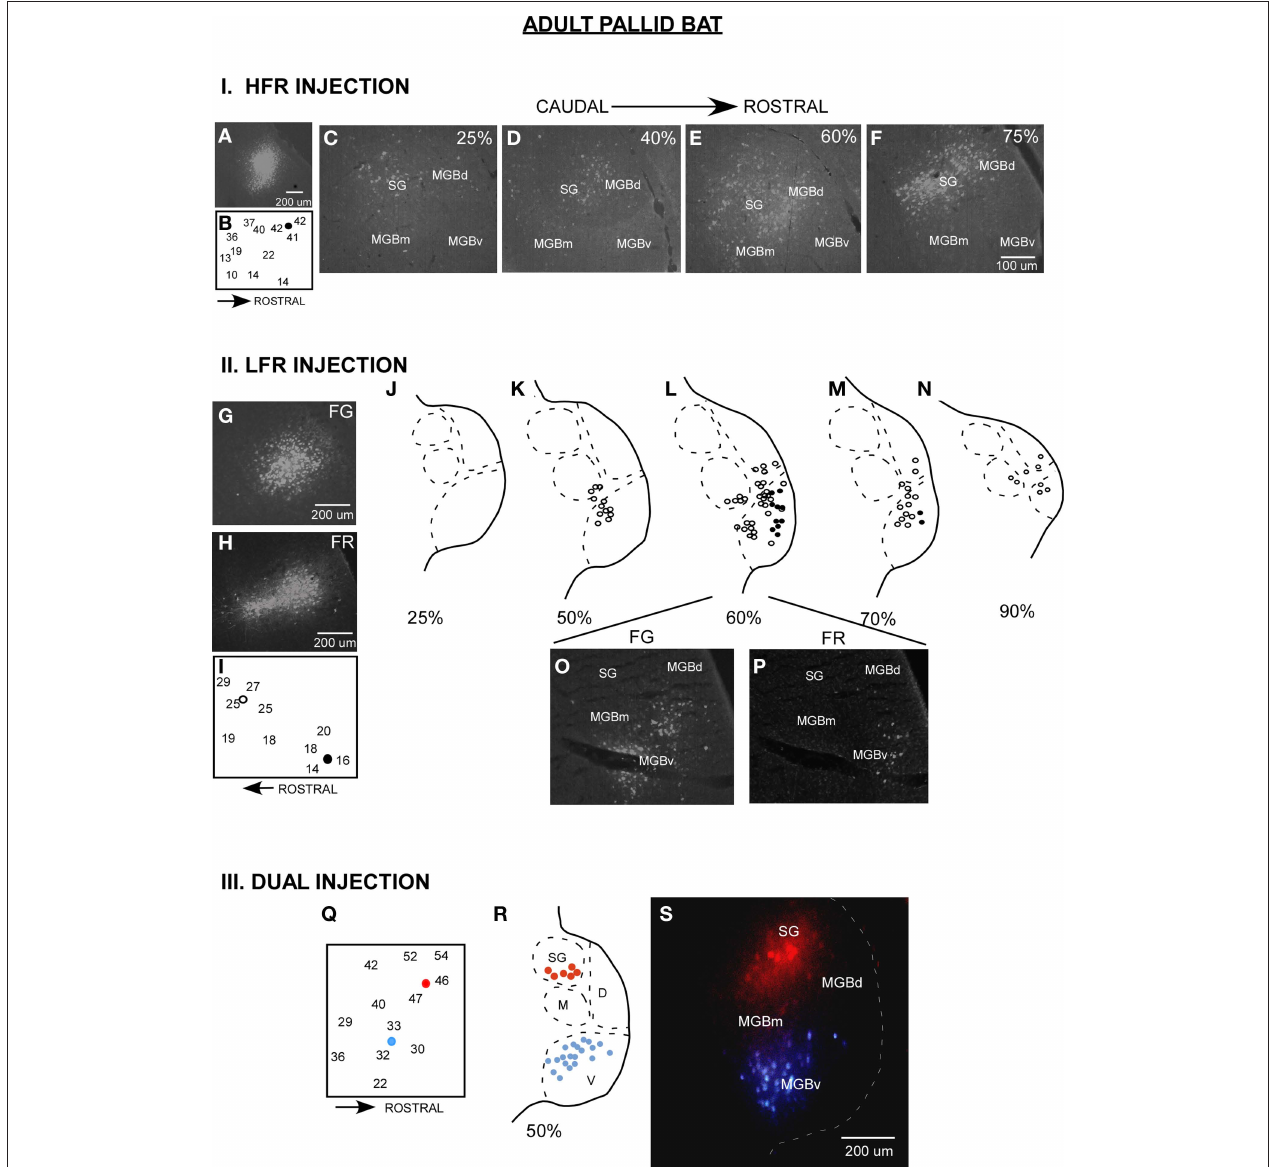
of increasingly rostral sections through the MGB showing that labeled neurons were found in the MGBv, MGBm, and MGBd, but not the SG. (O,P) Photomicrographs showing FG and FR labeled cells near the rostrocaudal center of the MGB. III (Q–S) An experiment in which FG was injected in the LFR and FR was injected in the HFR. (Q) Schematic of injection sites. (r) Schematic of a section at the rostrocaudal center of the MGB showing that FG labeled neurons were present in MGBv, but not the SG, and that FR labeled cells were found in the SG, but not the MGBv. (S) Photomicrograph of the section shown in (r)